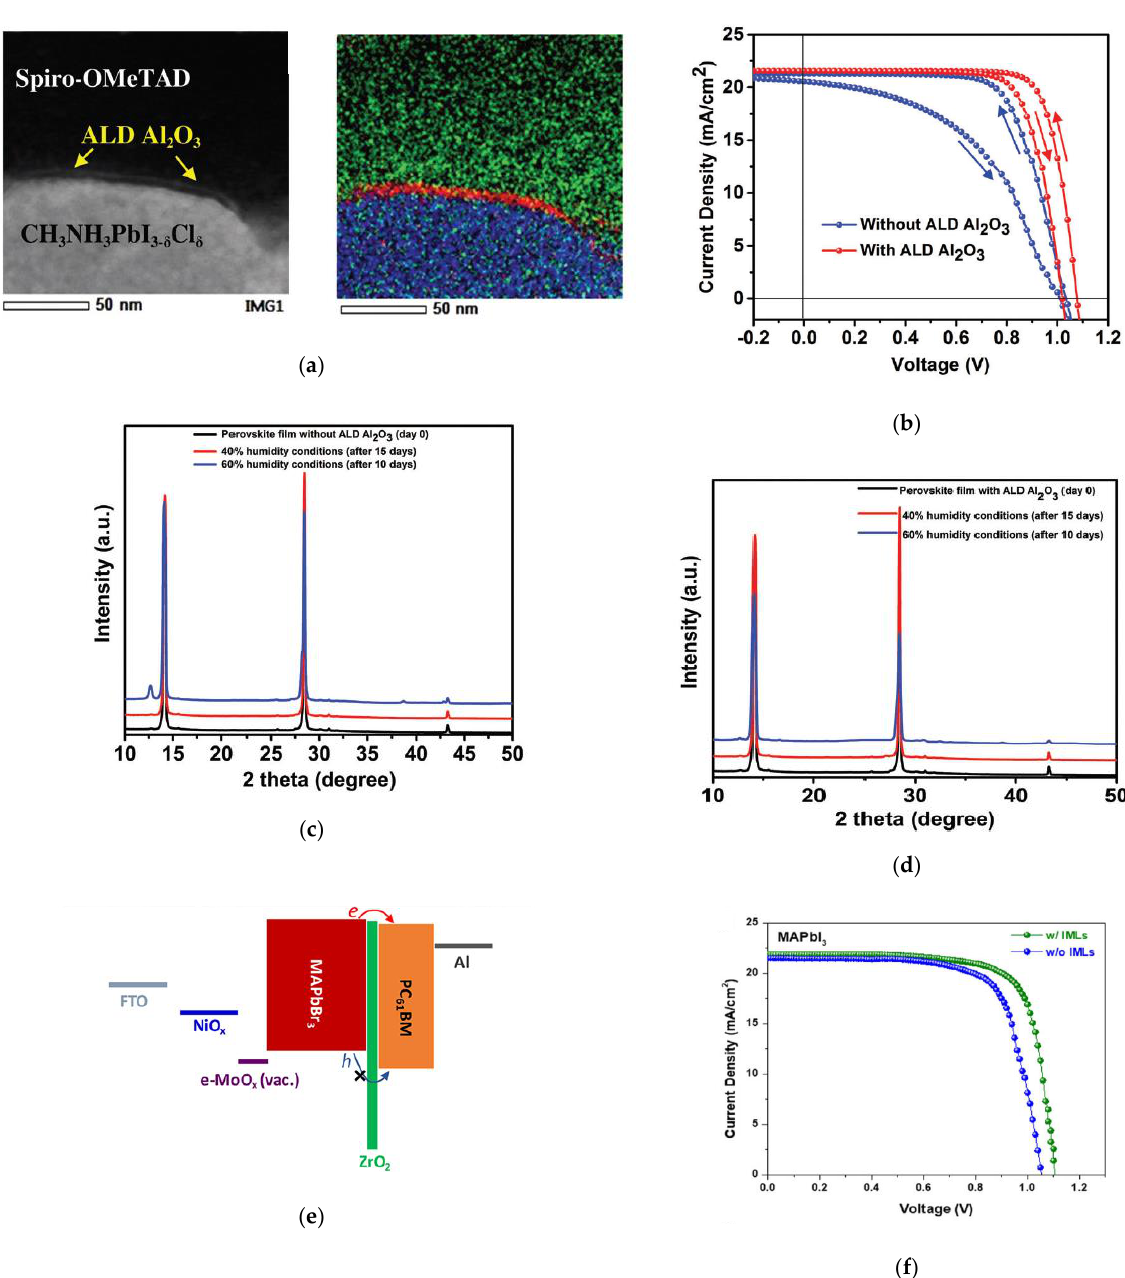
Figure 4. Incorporation of ALD Al 2 O 3 as passivation layer in PSC: ( a ) high angle annular dark field (HAADF) scanning transmission electron microscopy (TEM) image of the perovskite/Al 2 O 3 /spiro-OMeTAD interface, and the corresponding overlapping elemental mapping image; ( b ) Illuminated J - V scans comparing PSCs without and with Al 2 O 3 ; ( c ) X-ray diffraction (XRD) scans of perovskite films without Al 2 O 3 ; ( d ) X-ray diffraction (XRD) scans of perovskite films with Al 2 O 3 . Reproduced from [62], with permission from the Royal Society of Chemistry, 2017. Incorporation of ALD ZrO 2 as barrier layer in PSC: ( e ) Illuminated current density vs. voltage comparing PSCs without and with the ALD Al 2 O 3 barrier layer; ( f ) Illuminated current density vs. voltage comparing PSCs with ALD TiO 2 -IrO x and nanoparticle NiO. Reproduced from [74], with permission from Wiley,